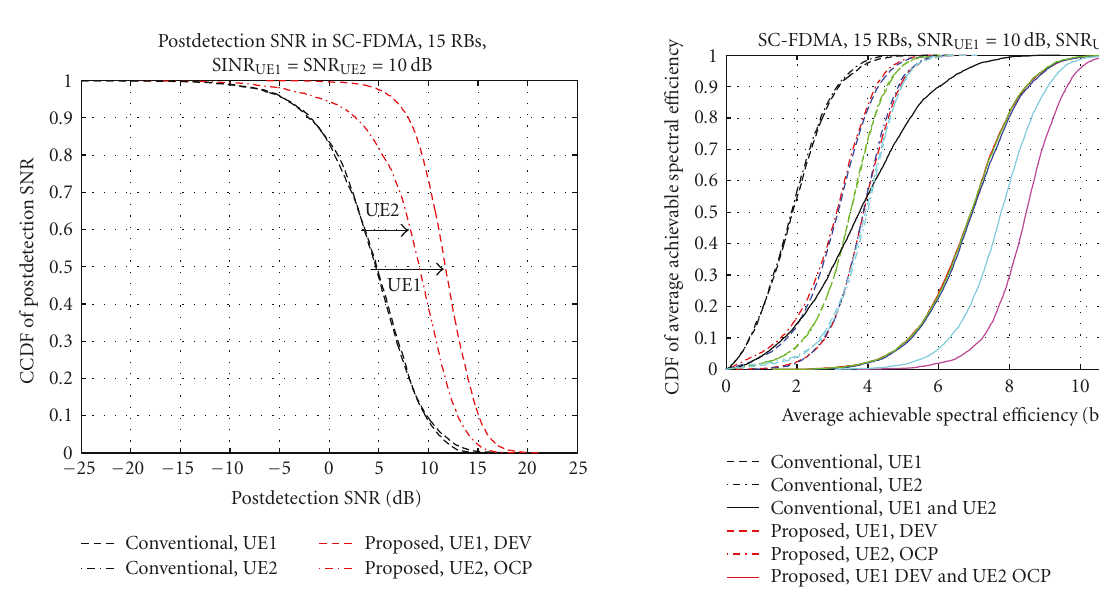
Figure 5: Complementary cumulative distribution function (CCDF) of the postdetection SNR between the conventional MIMO SC-FDMA and the proposed MIMO SC-FDMA with spatial precoding. 15RBs are available in the system and both UEs have the same average received SNR of 10dB.